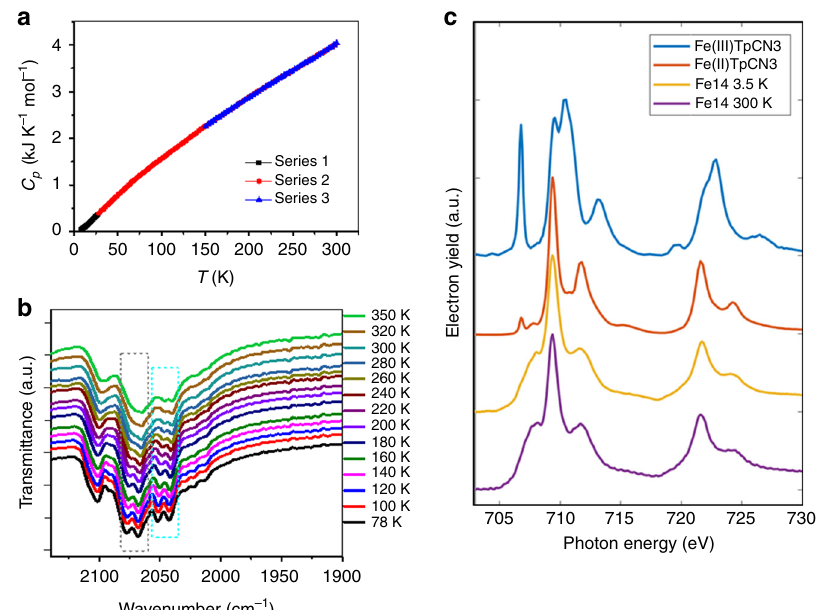
Fig. 3 Thermal dependence of the intramolecular electron transfer rate. a Zero- fi eld molar heat capacity of the [Fe 14 ] sample at temperatures of 7 – 300 K. The series 1, 2 and 3 denote the repeatability of the data in three-testing in the different temperature ranges. b In situ temperature-dependent infrared spectra of [Fe 14 ] in the solid state. The dashed rectangles are guided for view to include the changing bands with temperature. c Stacked L-edge XAS for the [Fe 14 ] complex measured at 300 and 3.5 K alongside the reference spectra of [Fe III (Tp)(CN) 3 ] and [Fe II (Tp)(CN) 3 ]. The [Fe II (Tp)(CN) 3 ] overlaps with all features in c within the [Fe 14 ] complex, whereas the [Fe III (Tp)(CN) 3 ] does not (in particular the peak at ~706.8 eV associated with transitions into the t 2g ( M / N μ B ) vs. applied fi eld in the range of 0 – 5 T at 2 K, as shown in Fig. 4b. The onset of magnetization in the applied fi eld is greater than that of six magnetically isolated centers (red line in Fig. 4b) and is closer to the Brillouin curve for one isotropic S = 14 center (blue line in Fig. 4b). Inclusion of weak ferromagnetic exchange coupling (green line) between B sites suitably reproduces the measured magnetization curve, indicating a ferromagnetic S = 14 ground state.